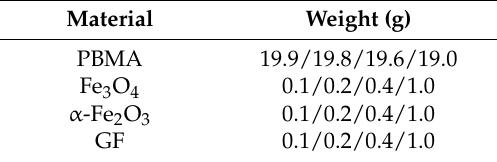
Table 1. Formulations of poly (butyl-methacrylate) inorganic particles